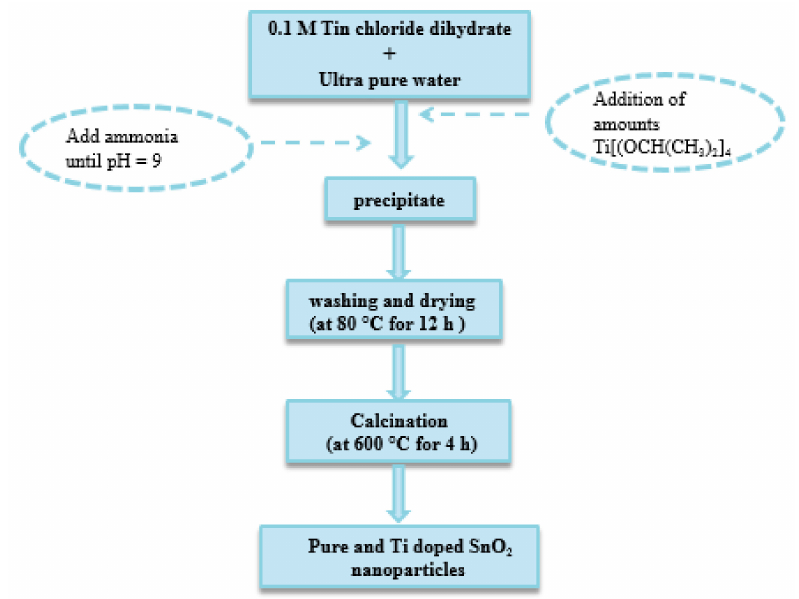
Figure 14. Flow process chart for the synthesis of Ti–SnO2